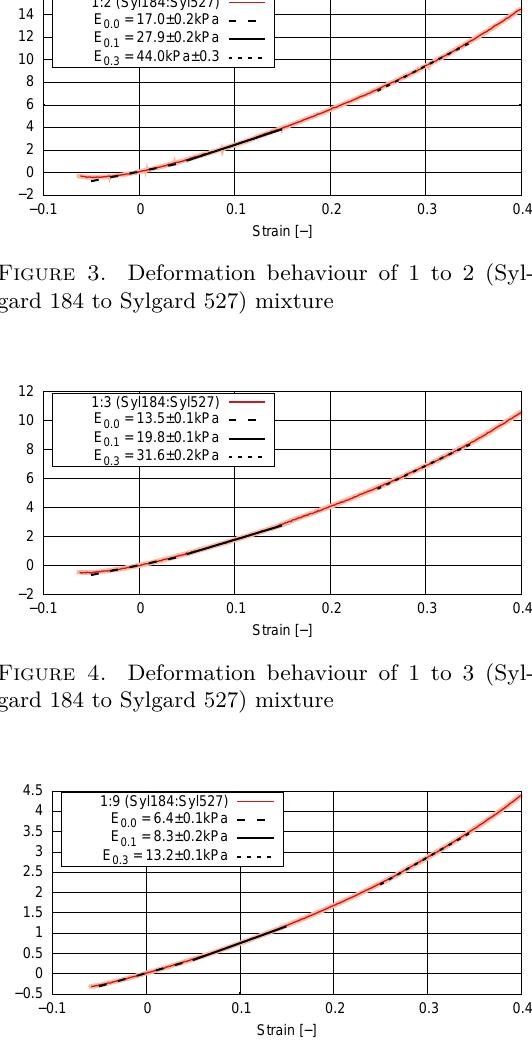
Figure 5. Deformation behaviour of 1 to 9 (Syl- gard 184 to Sylgard 527) mixture